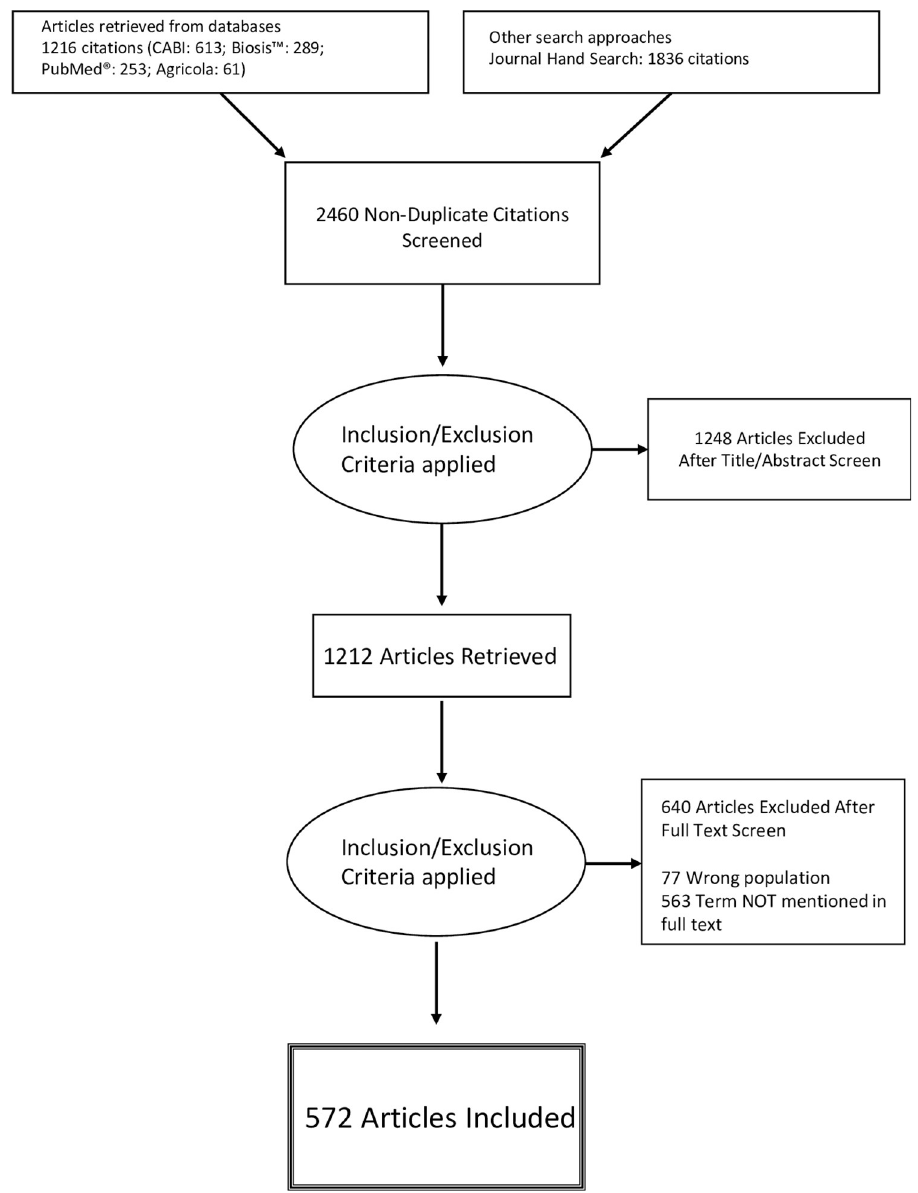
Fig 1. PRISMA flowchart. This flowchart depicts article inclusion for allostasis and allostatic load in non-human animal species.